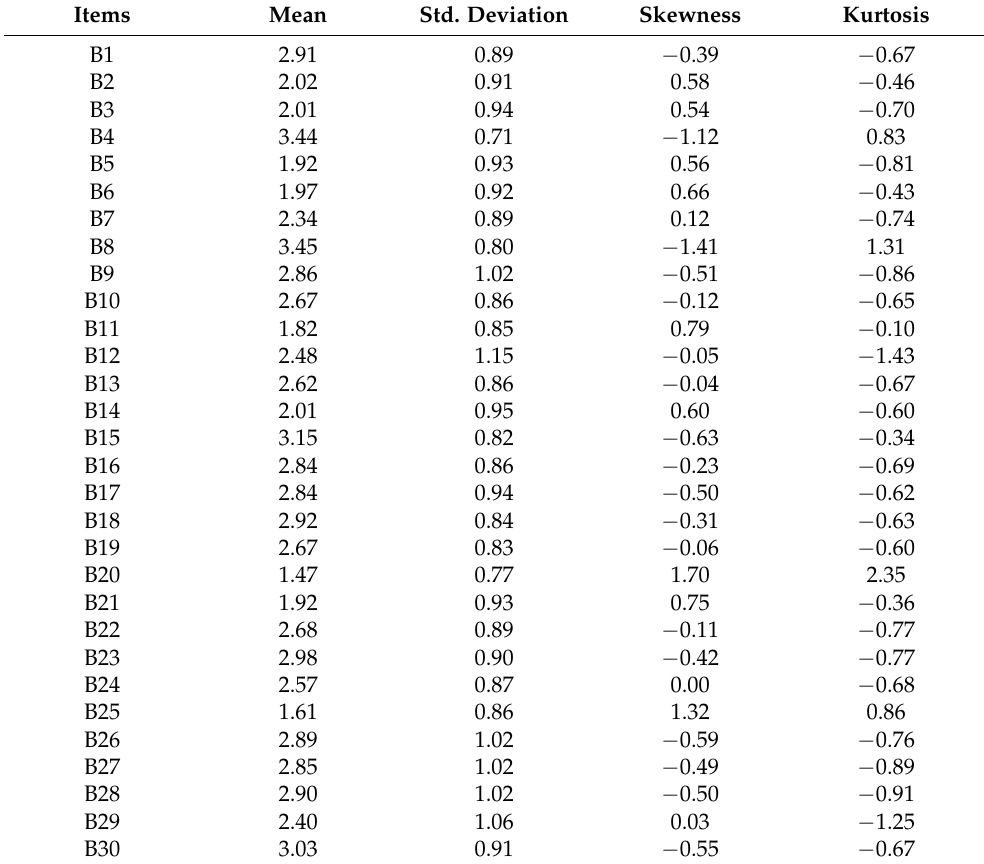
Table 2. Descriptive statistics for items scores.